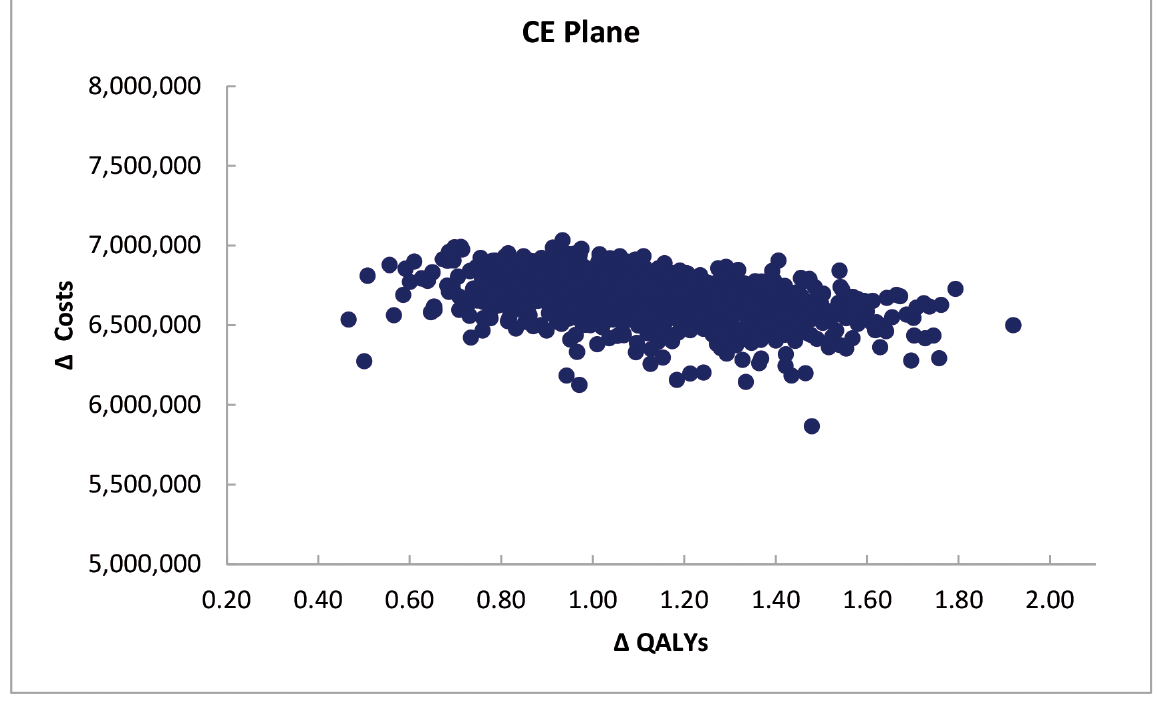
CE=cost effectiveness; QALY=quality-adjusted life